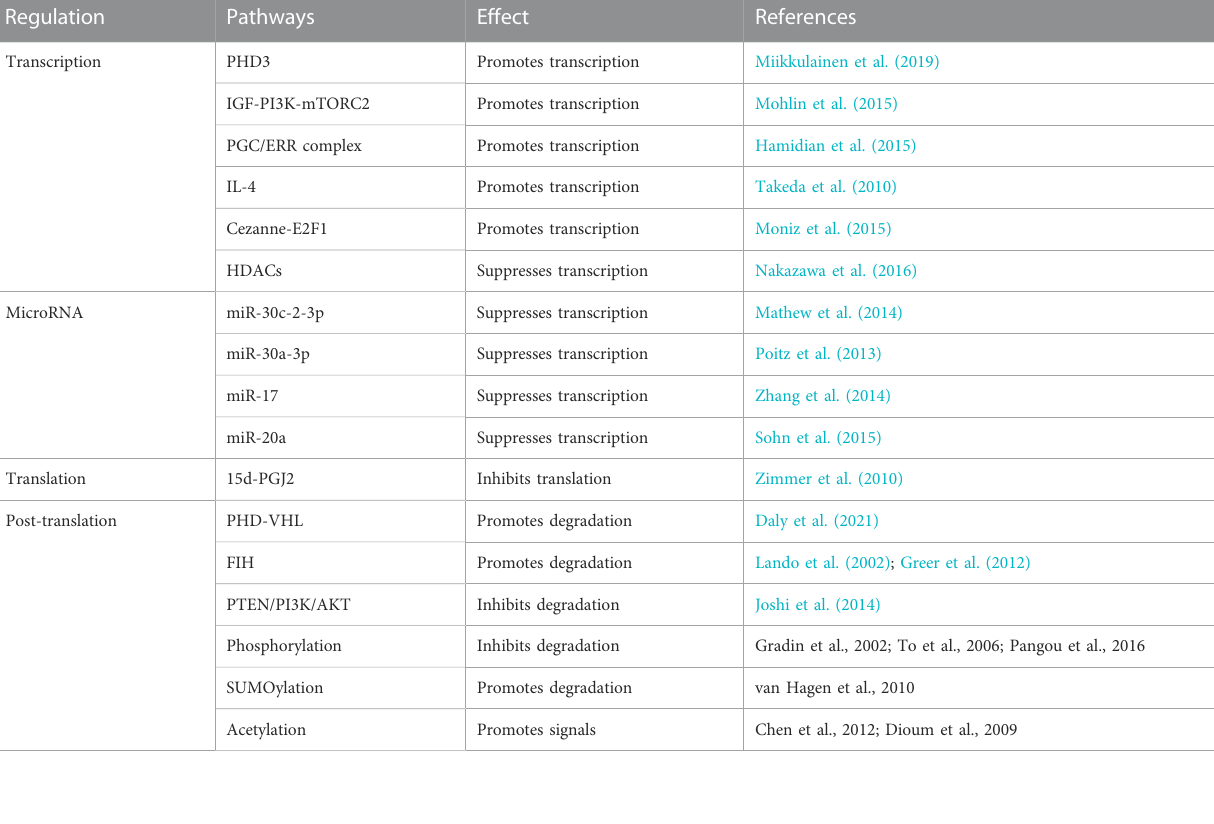
TABLE 1 Regulations of HIF-2 α .